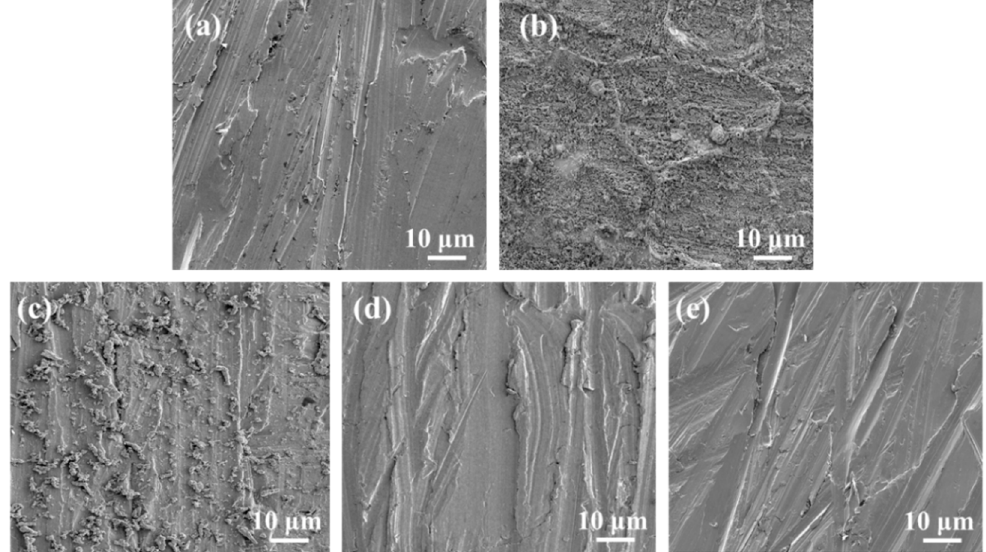
Figure 9. SEM images for ( a ) ground CRS, and the surface of CRS coated with the ( b ) bare, ( c ) PI, ( d ) AT and ( e ) EIO immersed in 3.5 wt.% NaCl solution duration for 30 days.